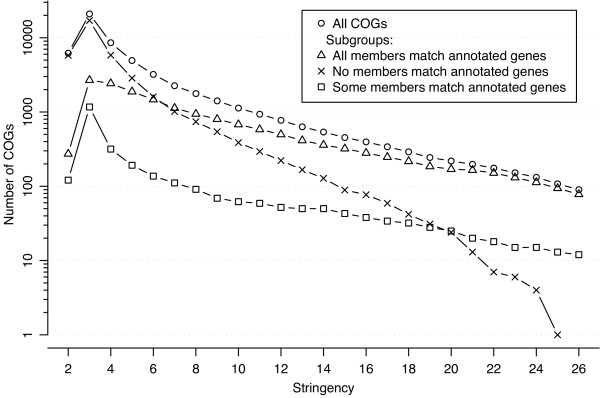
Presence of annotated genes in COGs of ORFs. Open reading frames (ORFs) of at least 90 nucleotides between stop codons were used to construct COGs at varying stringencies as described in the methods. COGs were divided into one of three groups: "All members match annotated genes" – contain only ORFs which correspond to annotated genes, "No members match annotated genes" – contain no ORFs which match annotated genes, or "Mixed" – contain some ORFs that correspond to annotated genes and some that do not. The numbers of ORFs in COGs of each of these classes are plotted along the y-axis with a logarithmic scale.